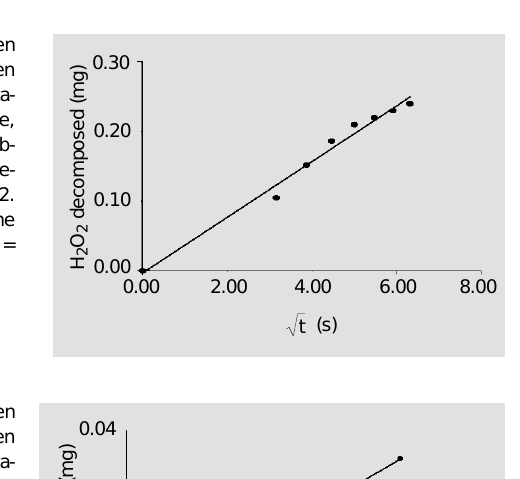
Figure 4 - Correlation between the amount (mg) of hydrogen peroxide decomposed by cata- lase as a function of mg hemo- globin. The equation of the straight line is y = 0.1726x + 0.0019. R 2 = 0.9818.